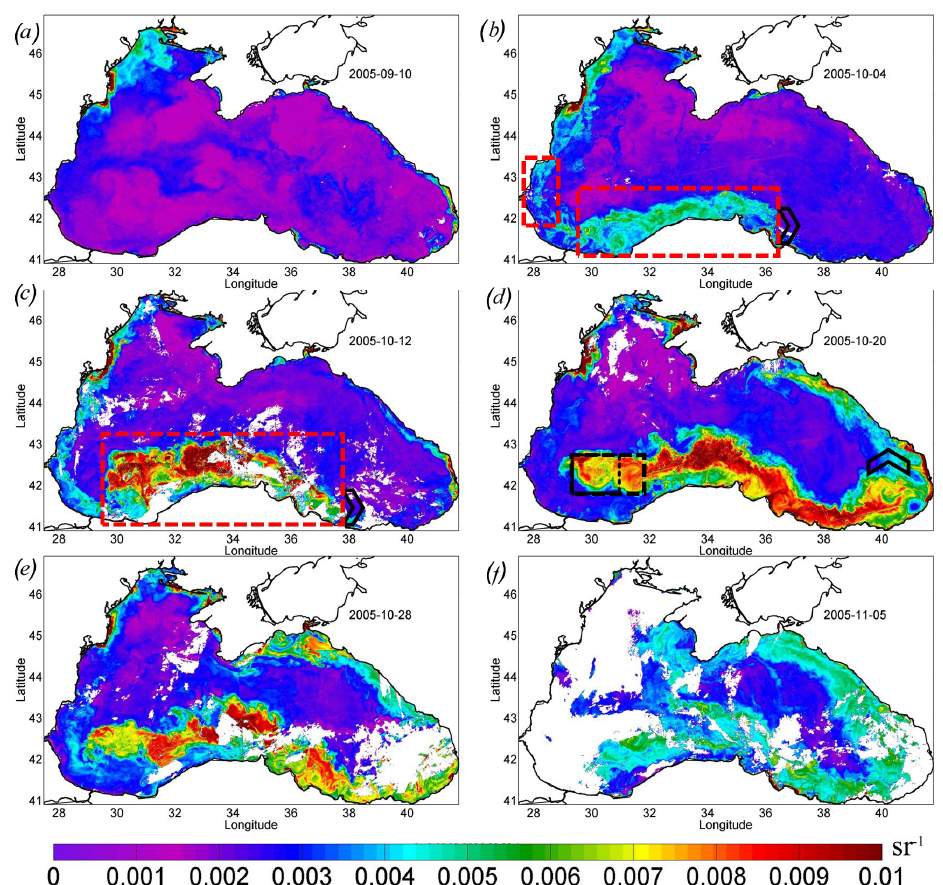
Figure 7. Maps of remote sensing reflectance R rs , per steradian, over 8d. (a) 10 September 2005. (b) 4 October 2005 – the red rectangles show the area of the initial start of the bloom. (c) 12 October 2005 – the red rectangle shows a mixing area. (d) 20 October 2005 – the black rectangle shows the center of the deep bloom in the western cyclonic gyre. (e) 28 October 2005. (f) 5 November 2005. The black arrowhead (b, c, d) shows the position of the eastern boundary of the